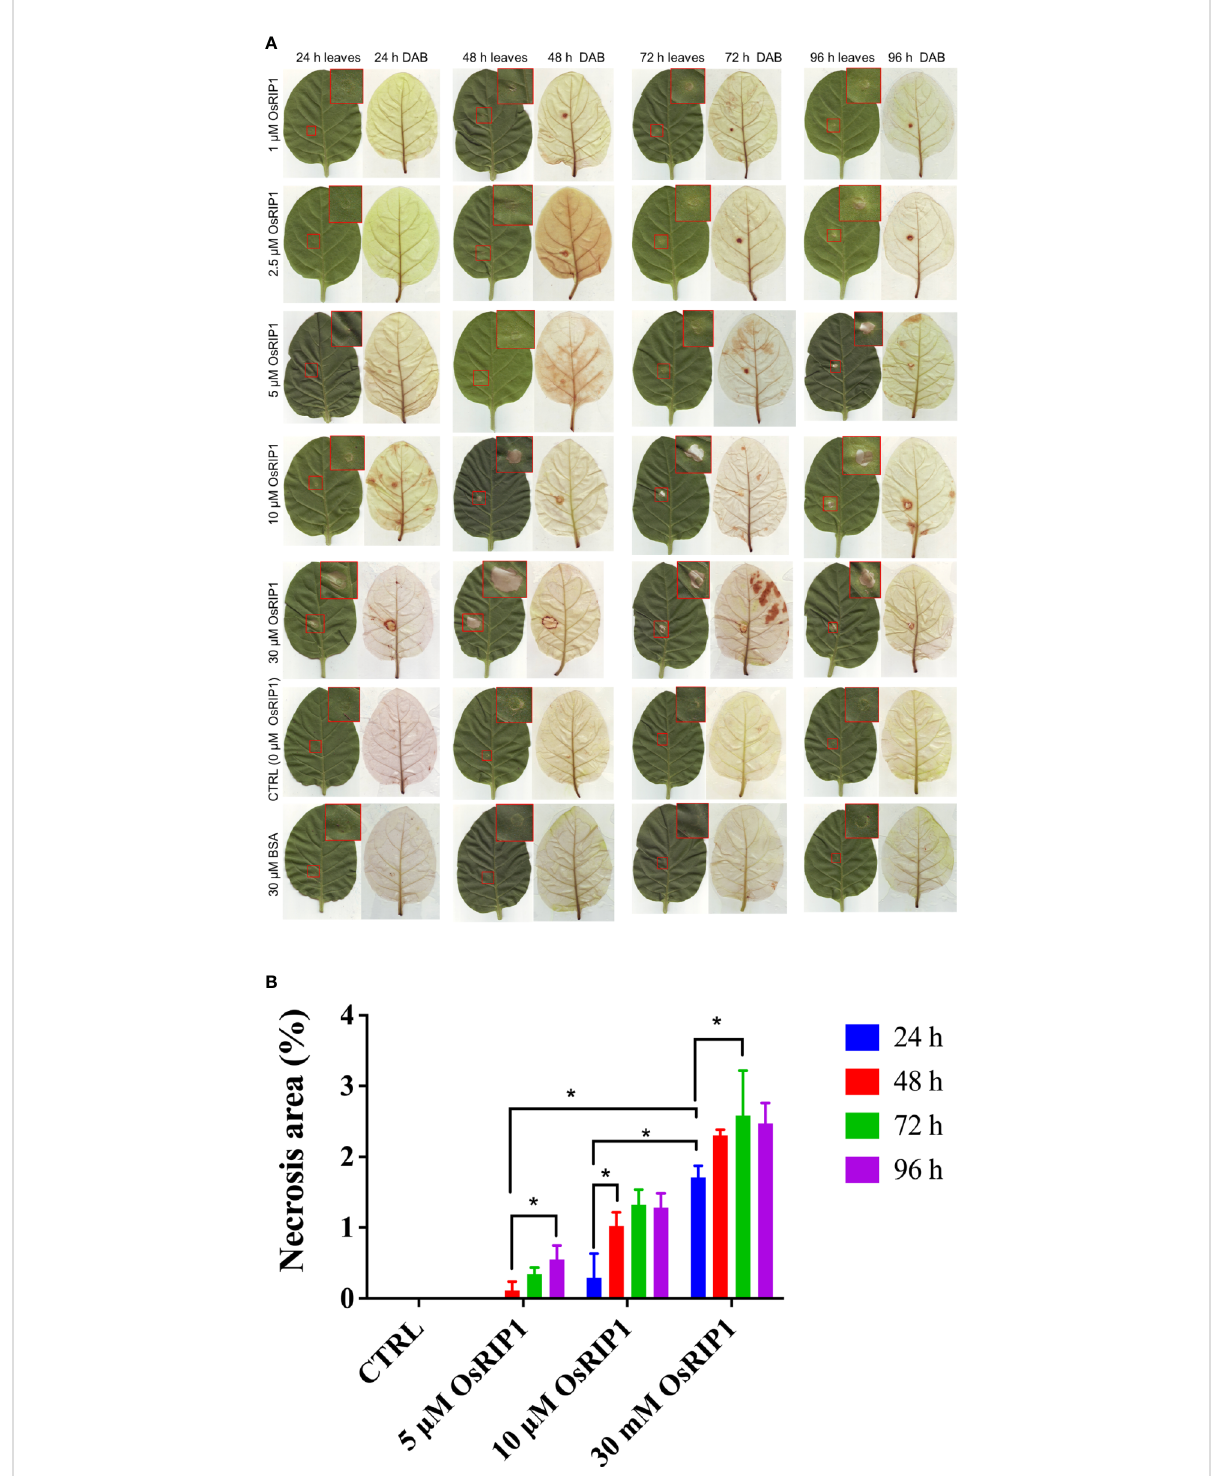
FIGURE 7 Leaves of 7-week-old Samsun NN tobacco plants were in fi ltrated with 50 mM potassium phosphate buffer (CTRL), with 30 m M BSA or with various concentrations of OsRIP1. (A) images of leaves after in fi ltration and chlorophyll removal after DAB staining. Brown DAB precipitates are indicative of the ROS burst. (B) necrotic area (% of the total leaf area) at different induction times post CTRL, BSA or OsRIP1 in fi ltration. At least three biological replicates were performed (n ≥ 3) for each treatment. Asterisks (*) indicate statistical difference (p <